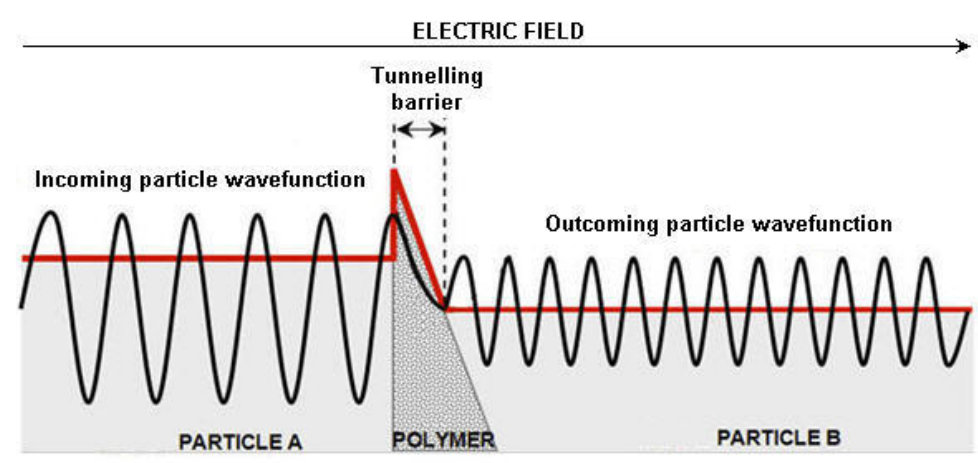
Figure 3. Schematic representation of quantum